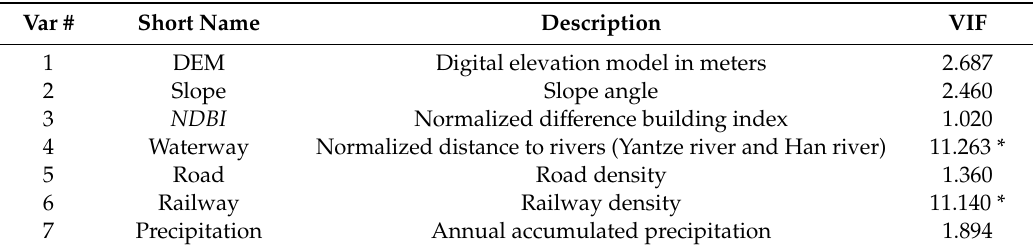
Table 4. Multicollinearity test for the selected variables correlated with the landscape